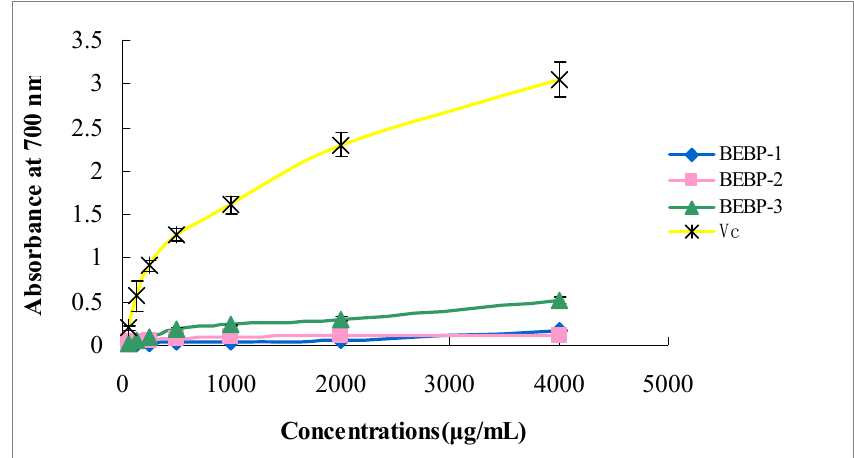
Figure 4. Effect of the polysaccharides on reducing power. Results are presented as means ± standard